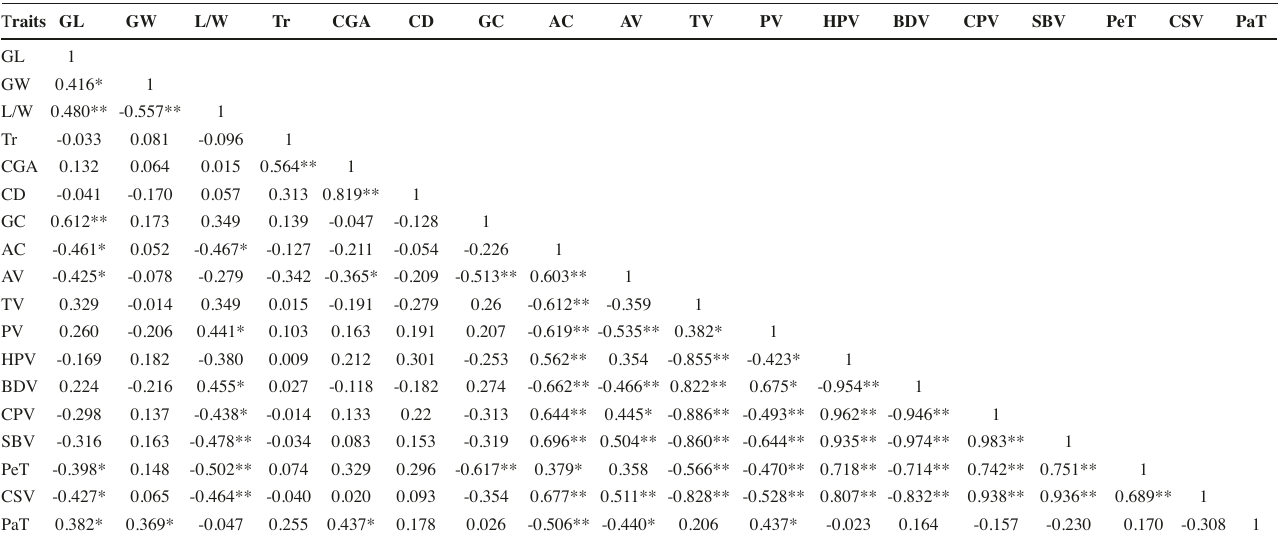
Tab. 2: Relationships between rice quality